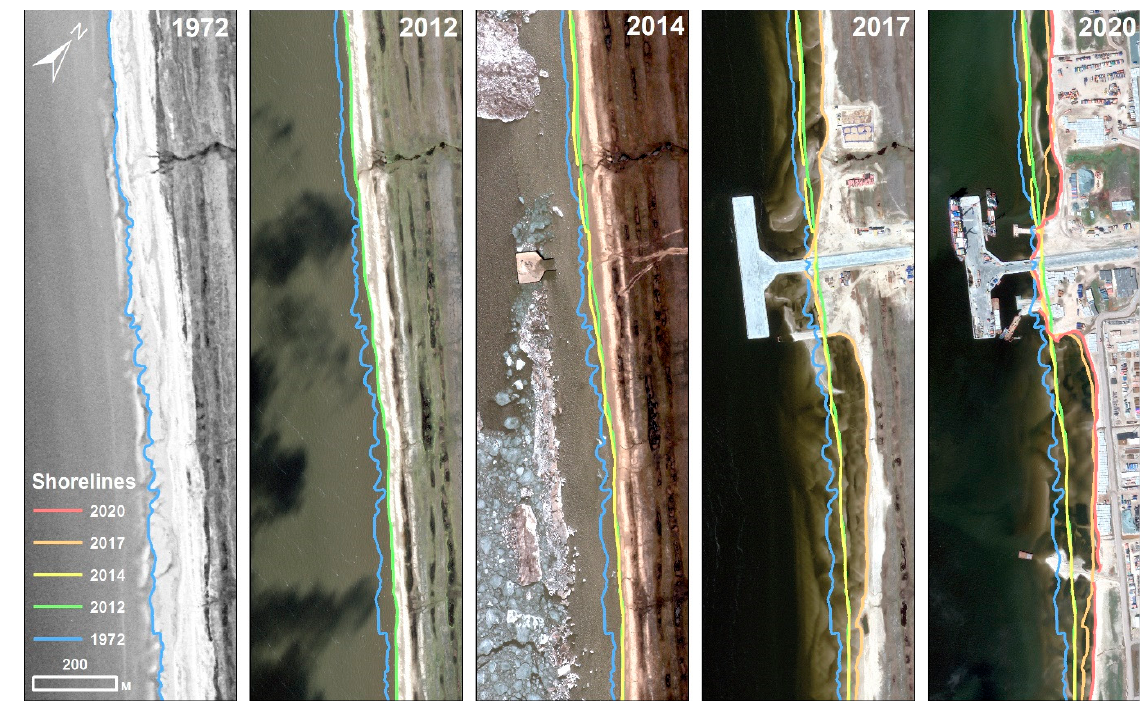
Figure 5. Shoreline position changes from 1972 to 2020 in the area with the highest rates of retreat.